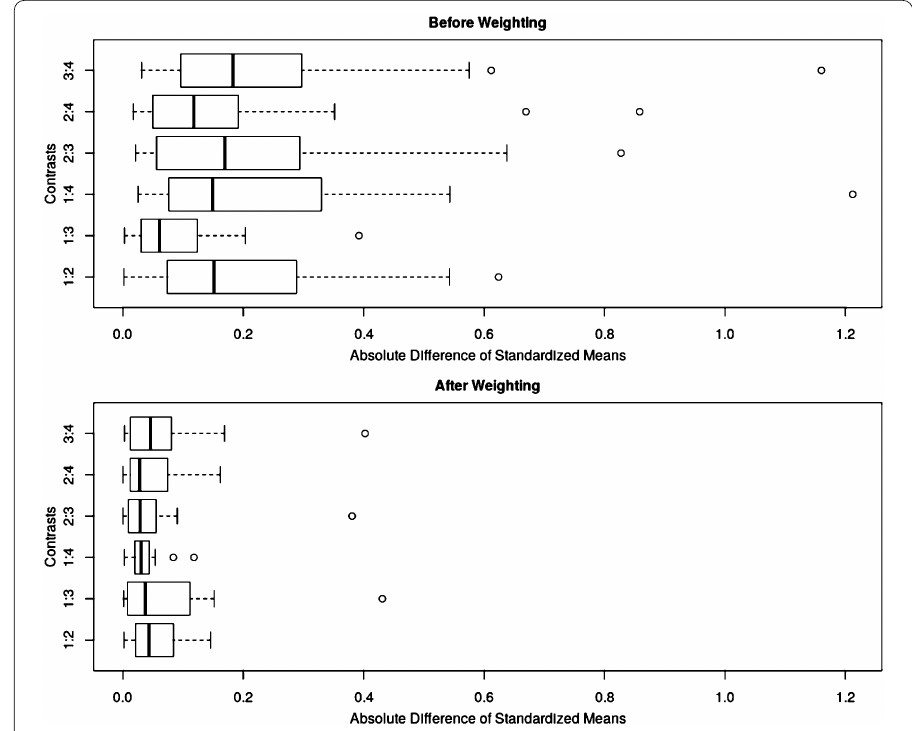
Figure 2 Comparing the covariate imbalance before and after weighting. Each point on the plot is a covariate and each boxplot represents the median, min and max (excluding the outliers), upper and lower quartiles of the covariates for each contrast. Comparing the covariate imbalance before (the upper panel) and after (the lower panel) weighting shows that the weighting is significantly reduced the imbalance across the treatment